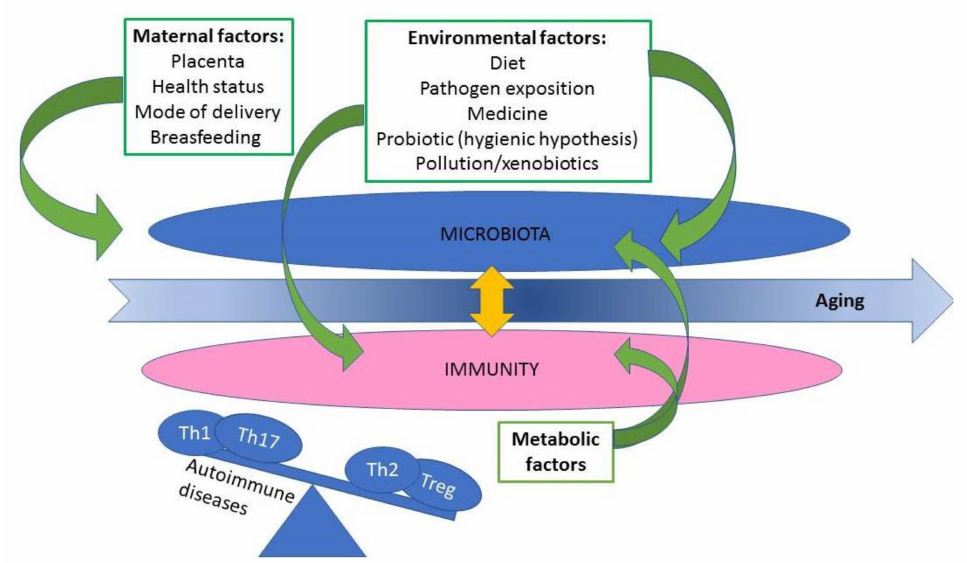
Figure 1. Scheme of the relationship between the microbiota, the immune system and other influ- encing factors. Changes in the microbiome may affect the balance of the lymphocyte subpopulation, contributing to the activation of the autoimmune